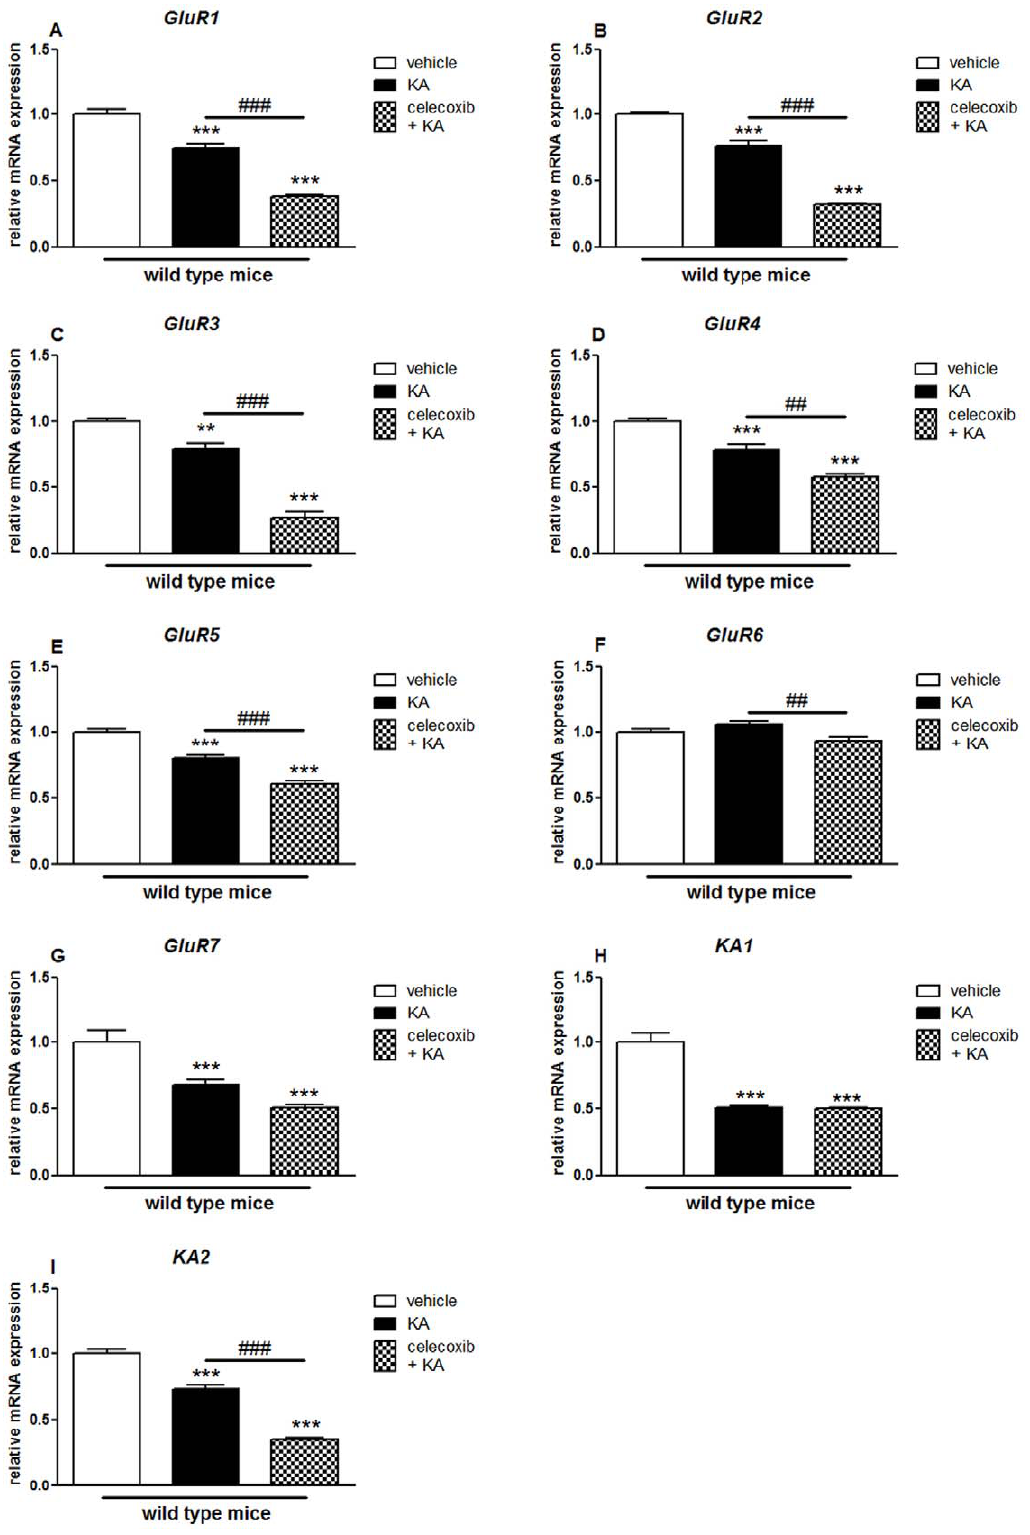
Figure 5. Effects of pretreatment with celecoxib on KA-induced expression of AMPA/KA receptor subunits in the hippocampus of wild type mice. Quantitative real time-PCR analysis of GluR1 (A), GluR2 (B), GluR3 (C), GluR4 (D), GluR5 (E), GluR6 (F), GluR7 (G), KA1 (H), KA2 (I) in WT mice, after two weeks treatment with celecoxib, followed by an i.p. injection of KA or vehicle 24 hours later. Data are means 6 SEM ( n =9). Statistical analysis was performed using a one-way ANOVA and Bonferroni’s post-hoc test. *P , 0.05, **P , 0.01, *** P , 0.001 compared to vehicle-injected WT mice; # P , 0.05, ## P , 0.01, ### P , 0.001 compared to KA-injected WT mice fi P , 0.05, fifi P , 0.01, fififi P , 0.001 between KA-injected COX-2 2 / 2 and KA-injected WT mice. doi:10.1371/journal.pone.0019398.g005 PLoS ONE |